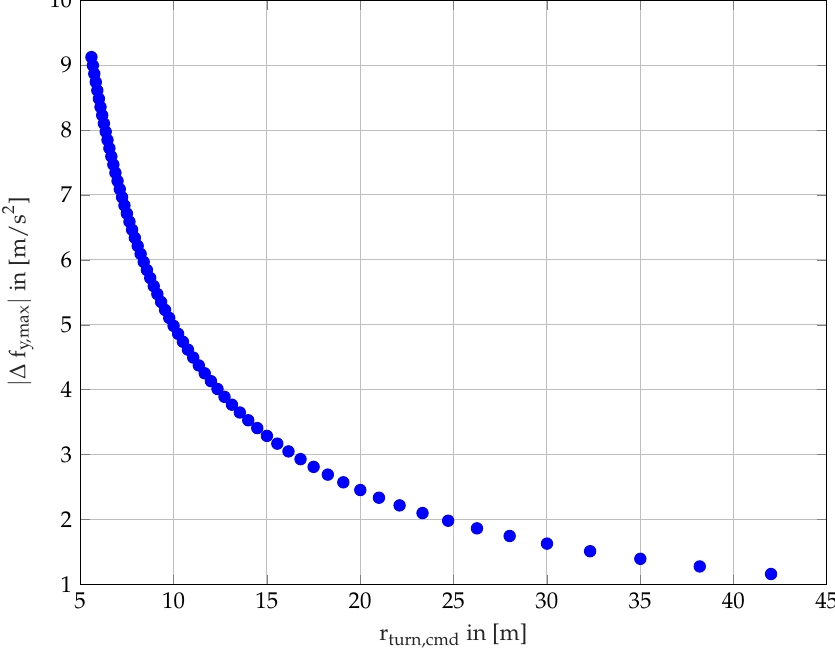
Figure 3. Maximal absolute lateral specific force over turn radius for 180° turn